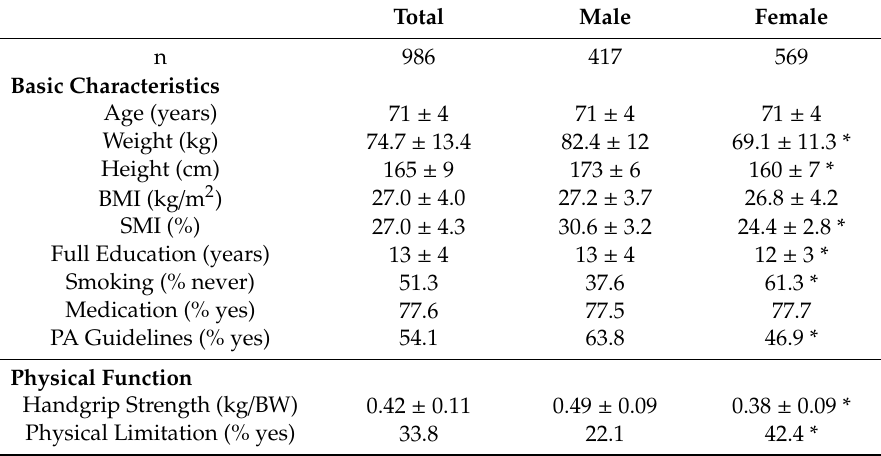
Table 1. General characteristics of the study